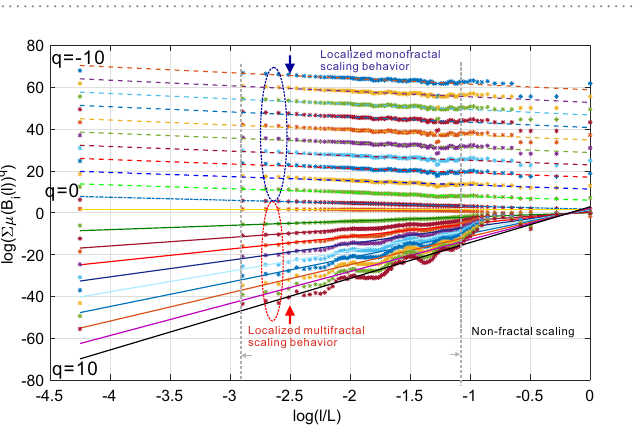
Figure 14. Distribution of probability measure as a function of scale of multi-fractal analysis on Budapest connectome network.